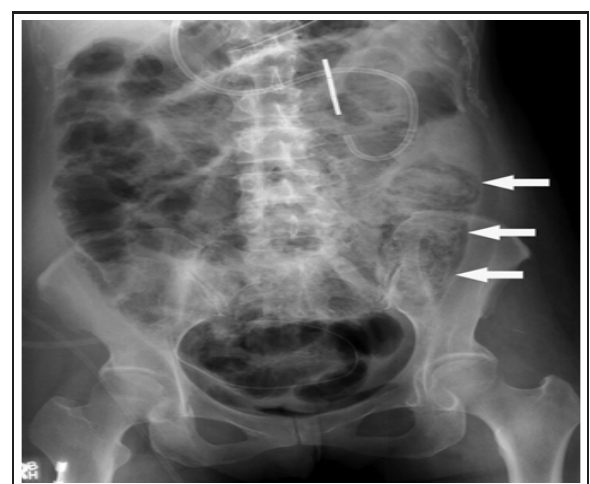
Figure 2a. Supine abdominal radiograph shows linear radiolucency (white arrows) along wall of bowel, which is consistent with pneumatosis intestinalis. Dilated loops of small bowel are also present.